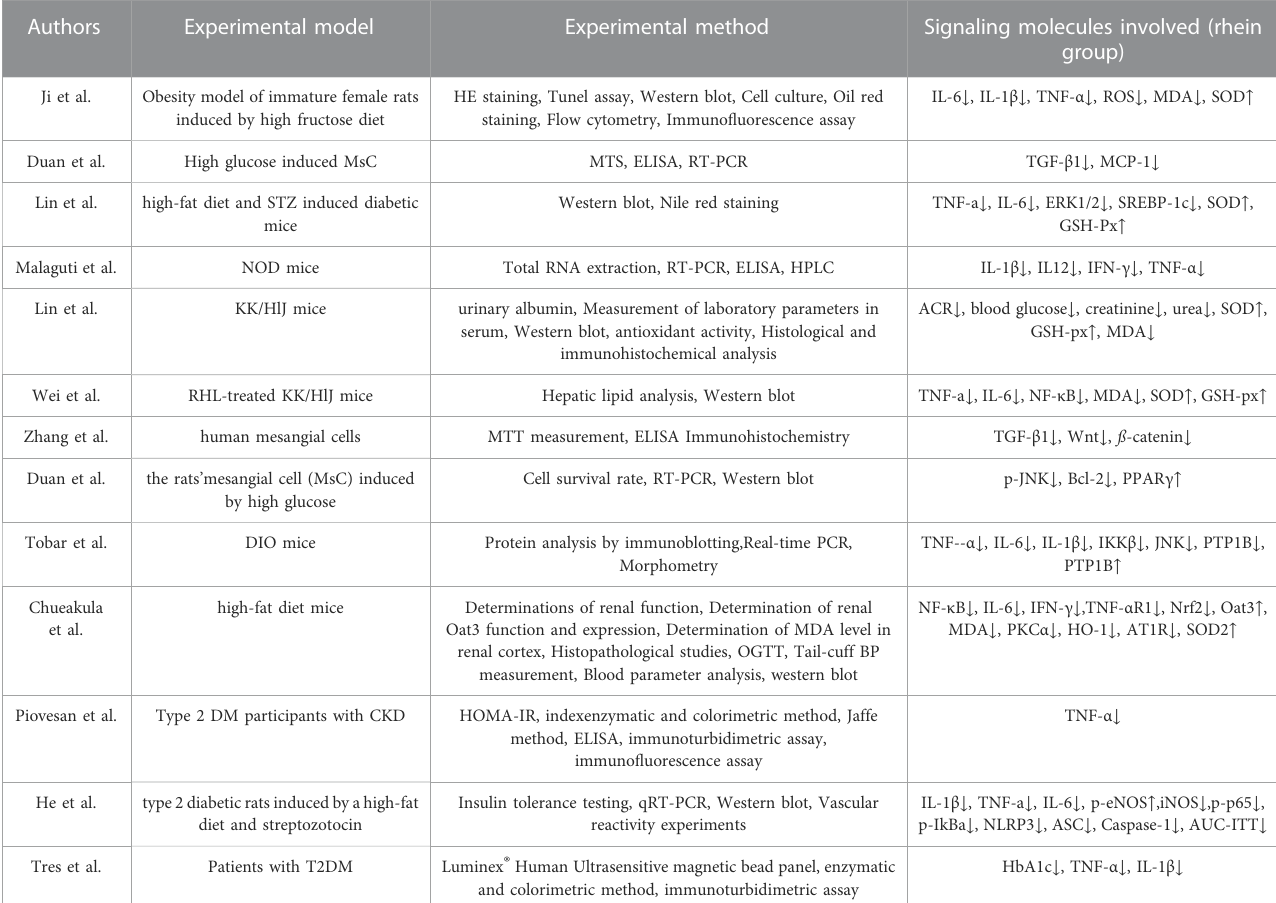
TABLE 1 Experiments on the anti-in fl ammatory mechanism of rhein in diabetes